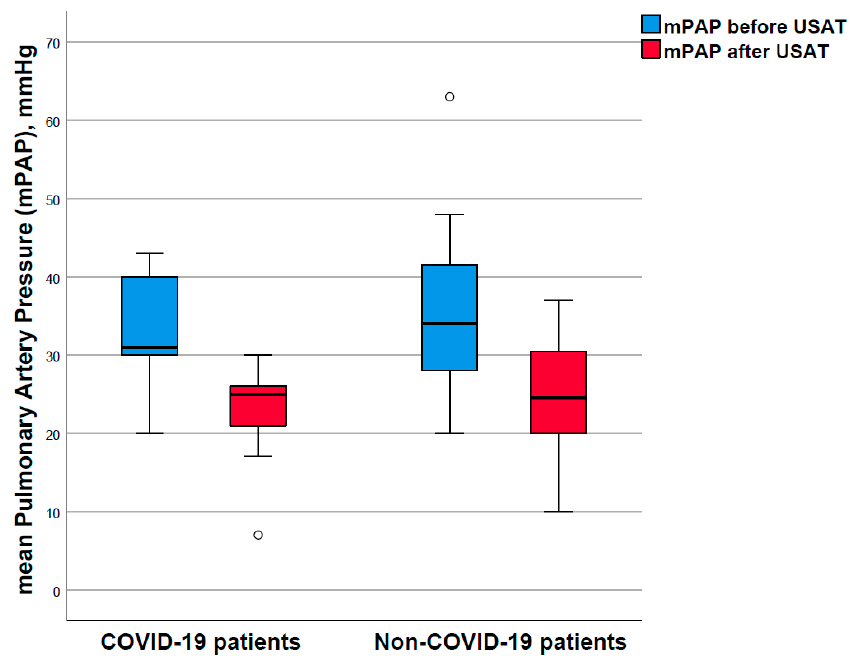
Figure 1. Invasively obtained mean pulmonary artery pressure before and after ultrasound-assisted catheter-directed thrombolysis (USAT). Patients with COVID-19-associated acute PE were age–sex- matched to patients without COVID-19 (1:3 ratio). Changes in the mean pulmonary arterial pressure (mPAP) before the treatment with ultrasound-assisted catheter-directed thrombolysis (USAT) and after the USAT: mPAP are depicted as median (Q1–Q3). Dots indicate outliers. Thicker lines indicate median values.